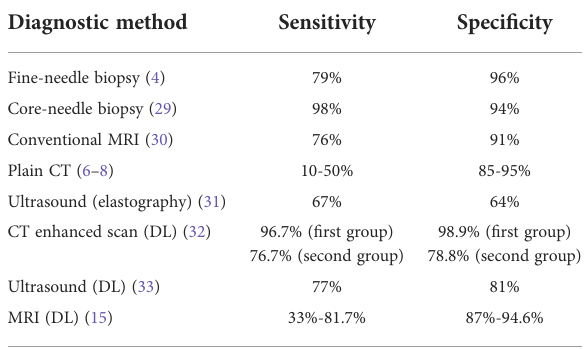
TABLE 5 The diagnostic sensitivity and speci fi city of different diagnostic methods.